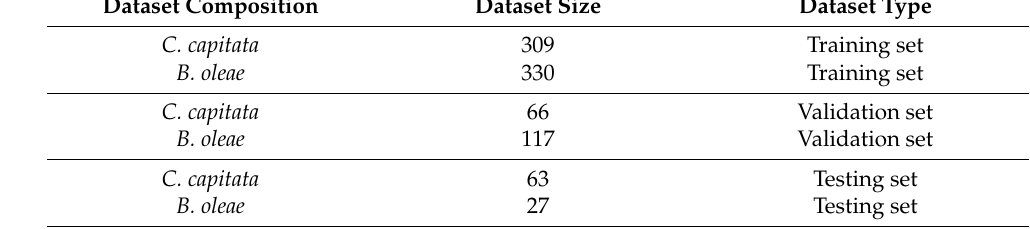
Table 1. Dataset composition, size, and type distribution.